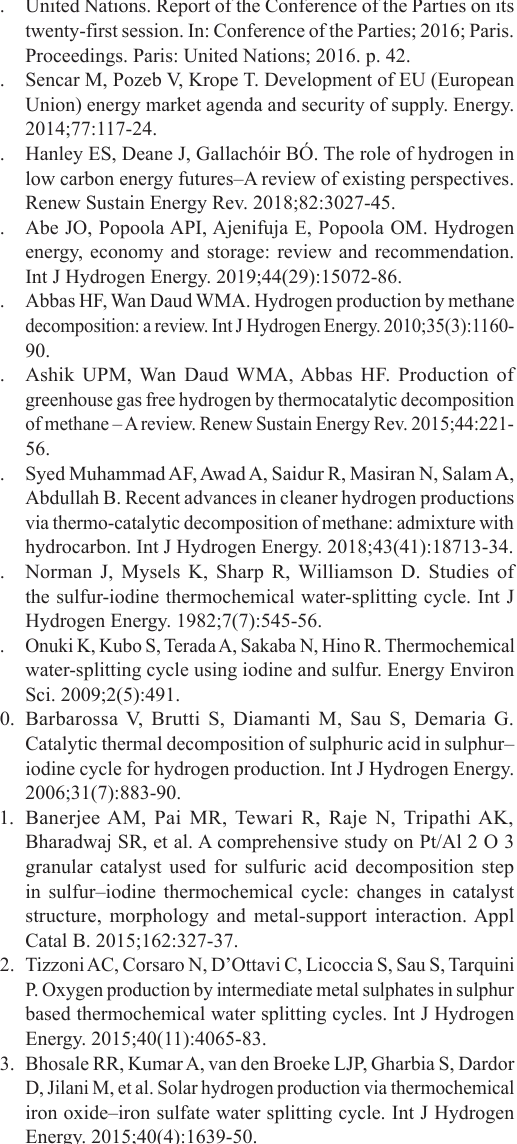
Table 1. Kinetic parameters associated with the MgSO processes with or without 20%(wt./wt.) of Pd/Al Chemical